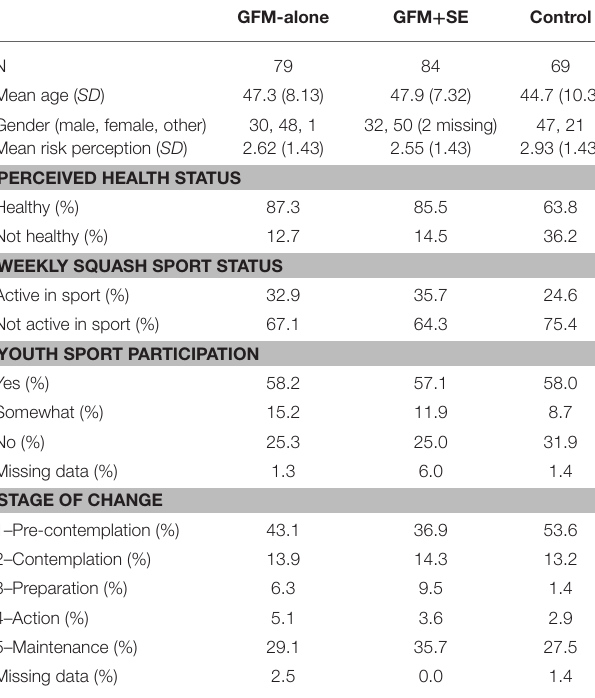
TABLE 1 | Descriptive statistics for demographic and screening variables at baseline.